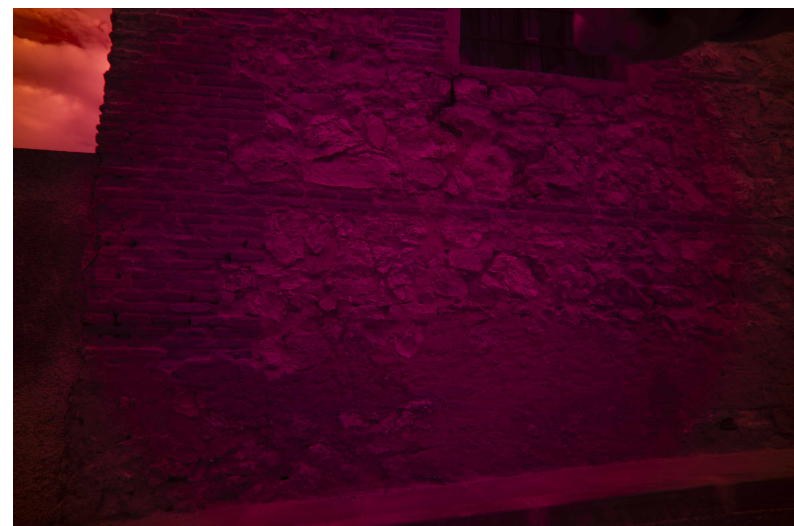
Figure 9. Photograph by modified camera mounting NIR/blue dualband pass filter.